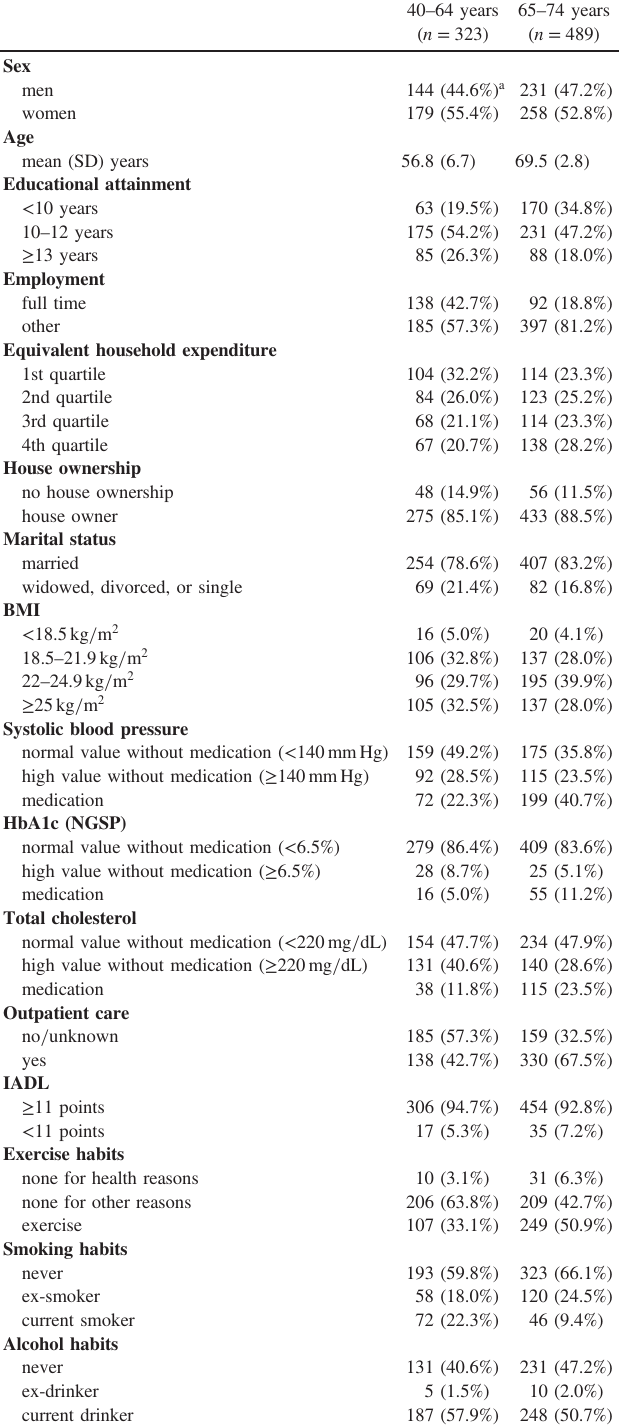
Table 1. Characteristics of the study population: NIPPON